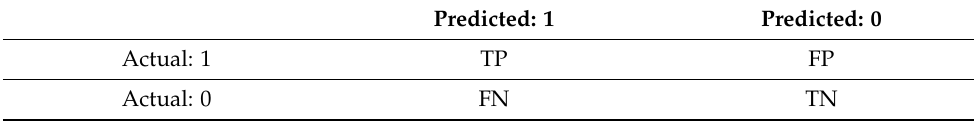
Table 2. Confusion matrix of classification